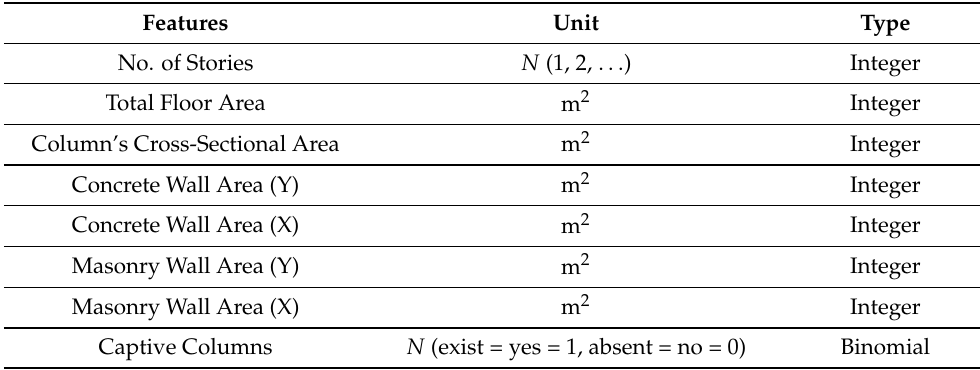
Table 1. RC buildings’ input feature collected for RVS study (based on the conducted study in